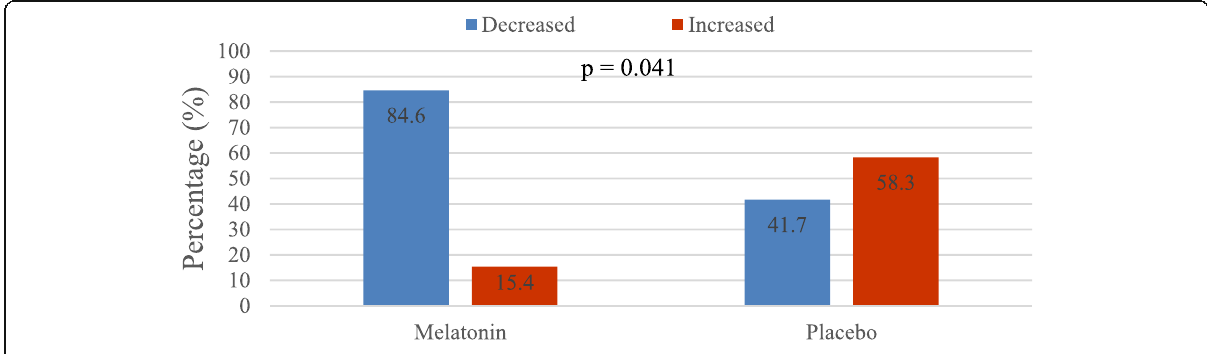
Fig. 2 Percentage of subjects showing change in CD44 expression